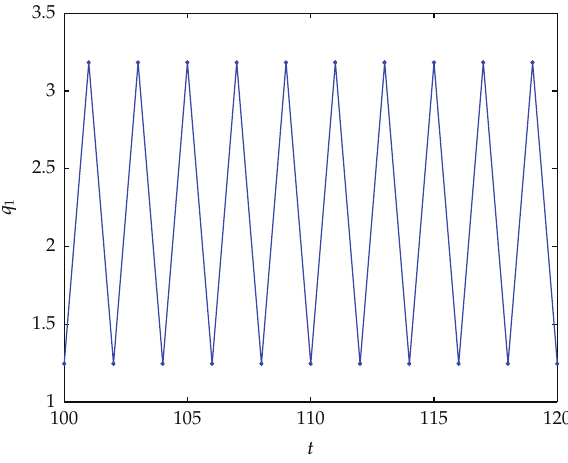
Figure 2: Period-2 cycle for β (cid:7) 0 . 2 ,α (cid:7) 19 .